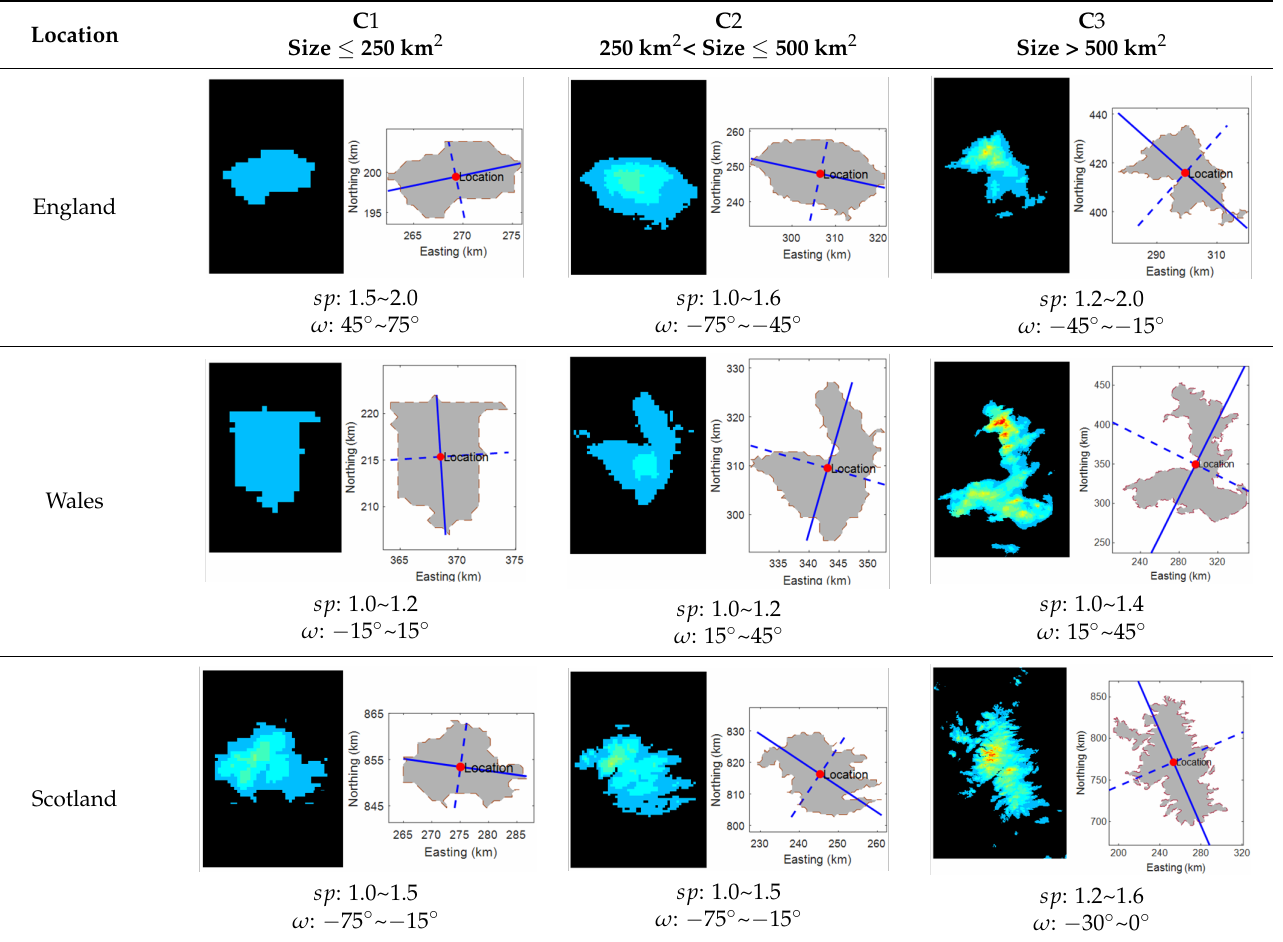
Table 1. Specific dominating patterns of daily rainfall in England, Wales, and Scotland catalogued in three